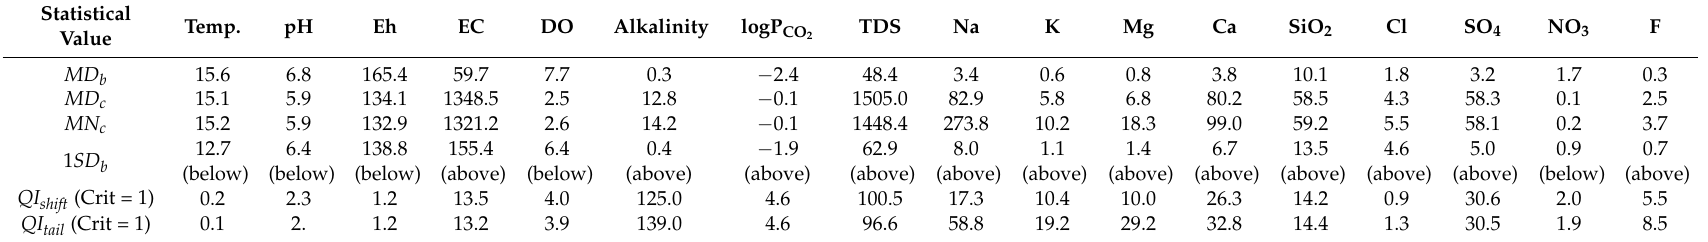
Table 4. Result of probability density function (PDF) verification for CO 2 -rich and ordinary groundwaters in Gangwon Province.